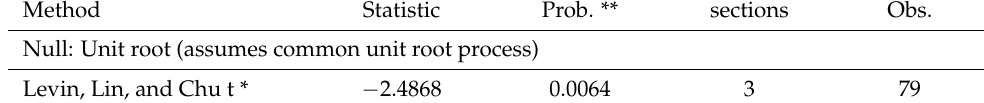
Table 2. Group unit root test: summary.